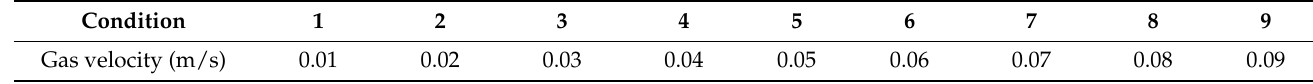
Table 1. Conditions of gas velocity.